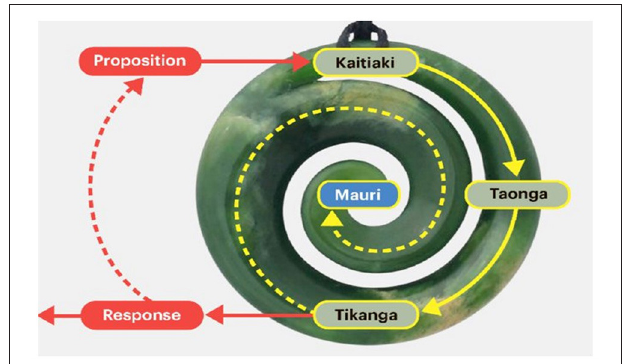
FIGURE 6 | The Mauriora Systems